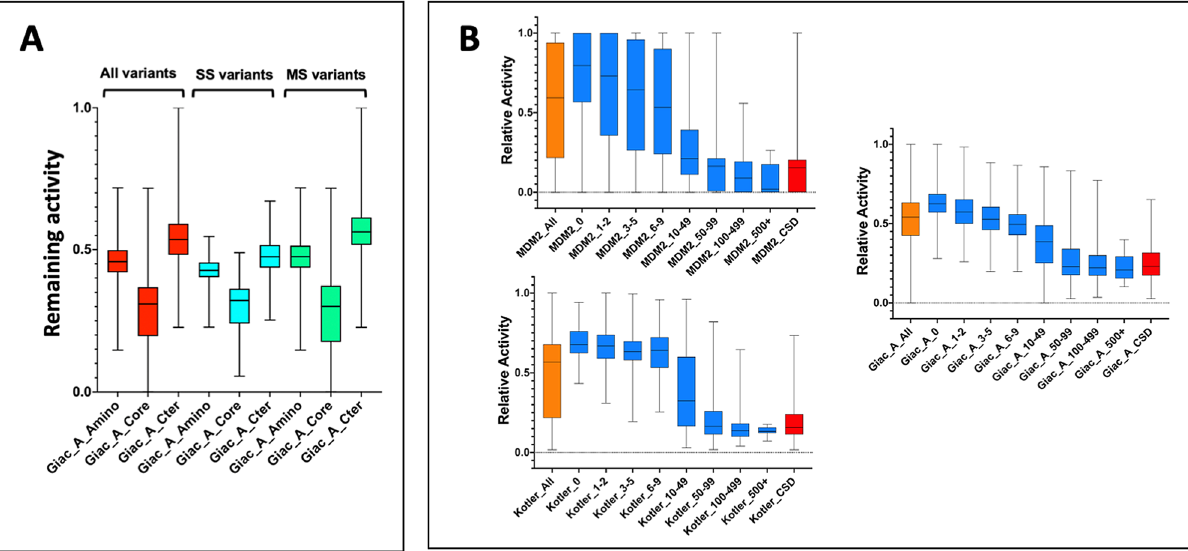
Figure 1. Functional analysis of TP53 variants. ( A ) TP53 variants from the core domain resulting from SNS, DNS and TNS are functionally impaired. TP53 variants were separated into 3 categories: amino (residues 1 to 99), core (residues 100 to 300) and carboxy (residues 301 to 393). Remaining activity ranging from 0 (no activity) to 1 (full activity) was determined from the normalized data of Giacomelli et al. 12 (see "Methods").